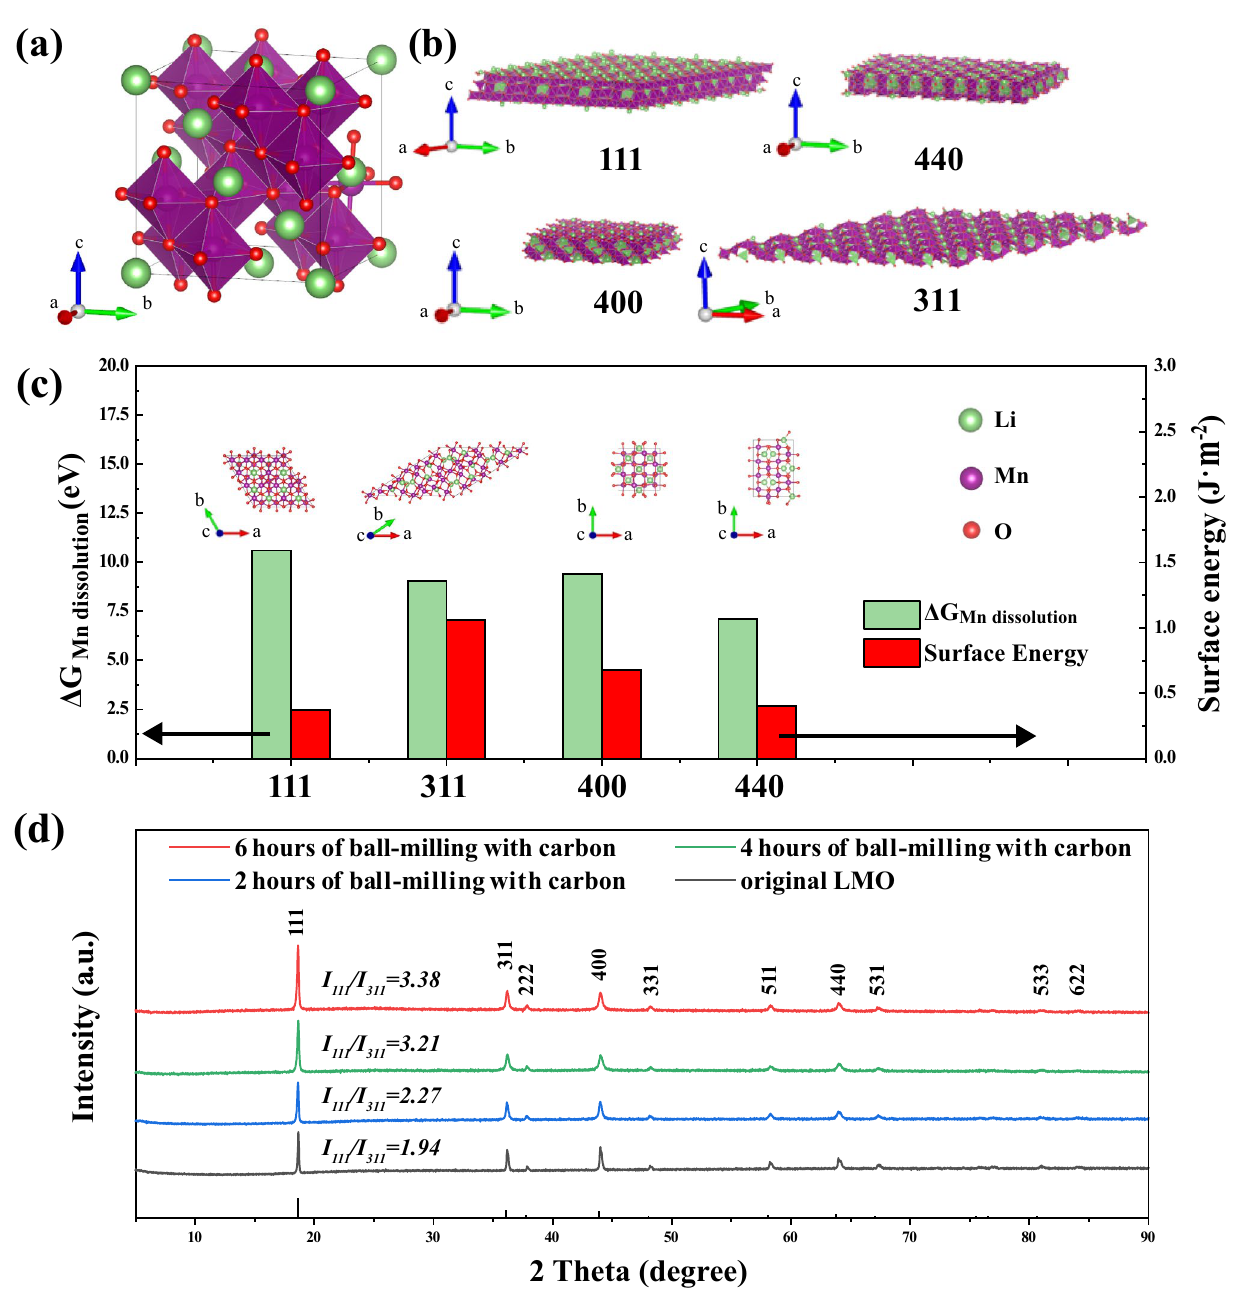
Fig. 1 a Crystal structure of LiMn 2 O 4, purple for manganese ions, green for lithium ions, and red for oxygen ions. b (111), (311), (400), and (440) facets. c Calculated results of the Gibbs free energy changes of Mn dissolution reactions and the surface energies of different lattice planes. d Comparison of XRD patterns of LMO after the ball-milling processes of different time lengths with the incorporation of